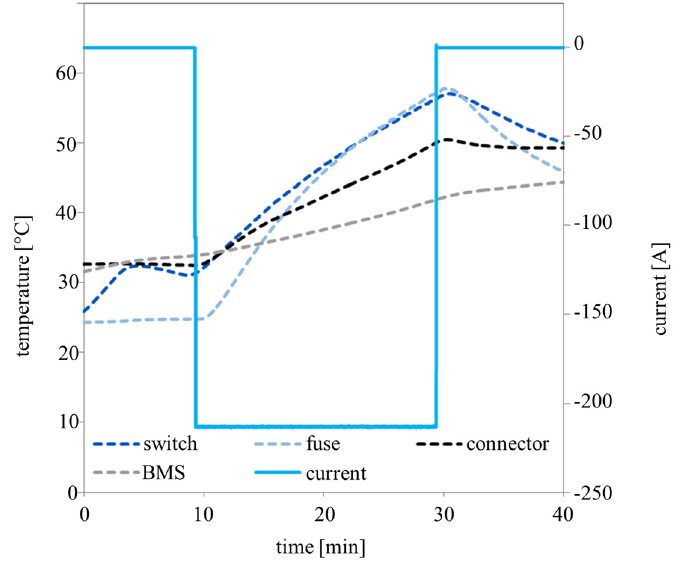
Figure 12. Heat up process of different pack components under